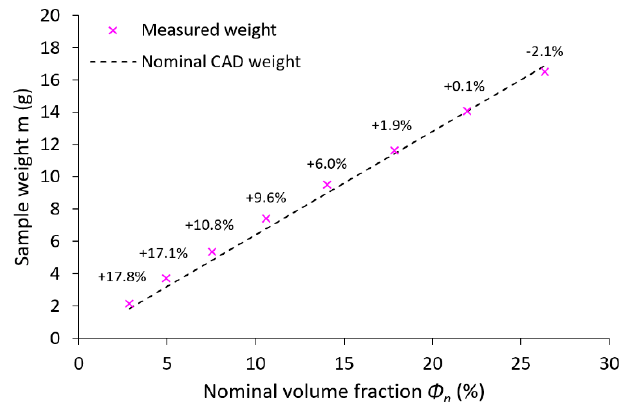
Figure 8. Comparison of the actual average and nominal weight of samples according to the nominal volume fraction; the numbers above points show the percentage of weight variation.